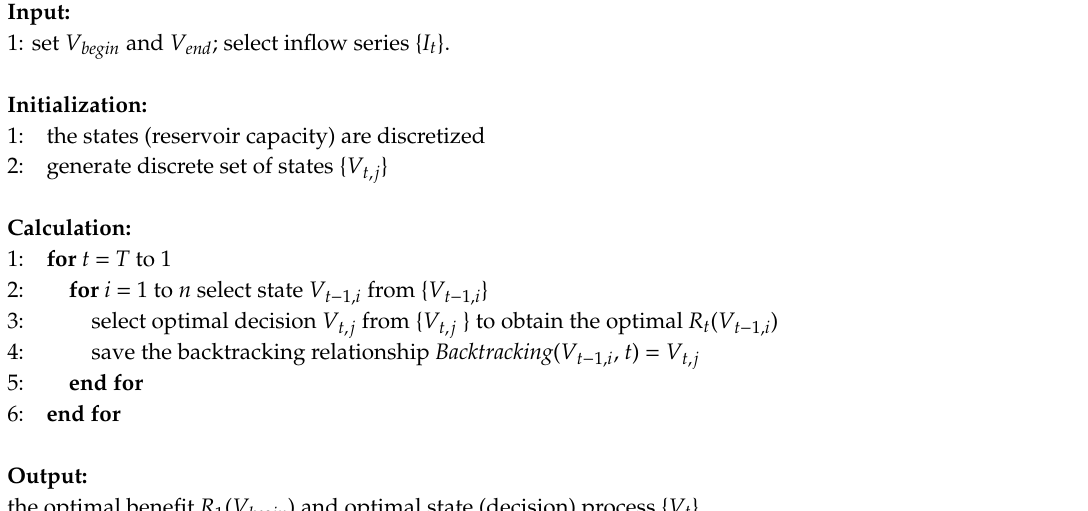
Algorithm 1 DP for reservoir